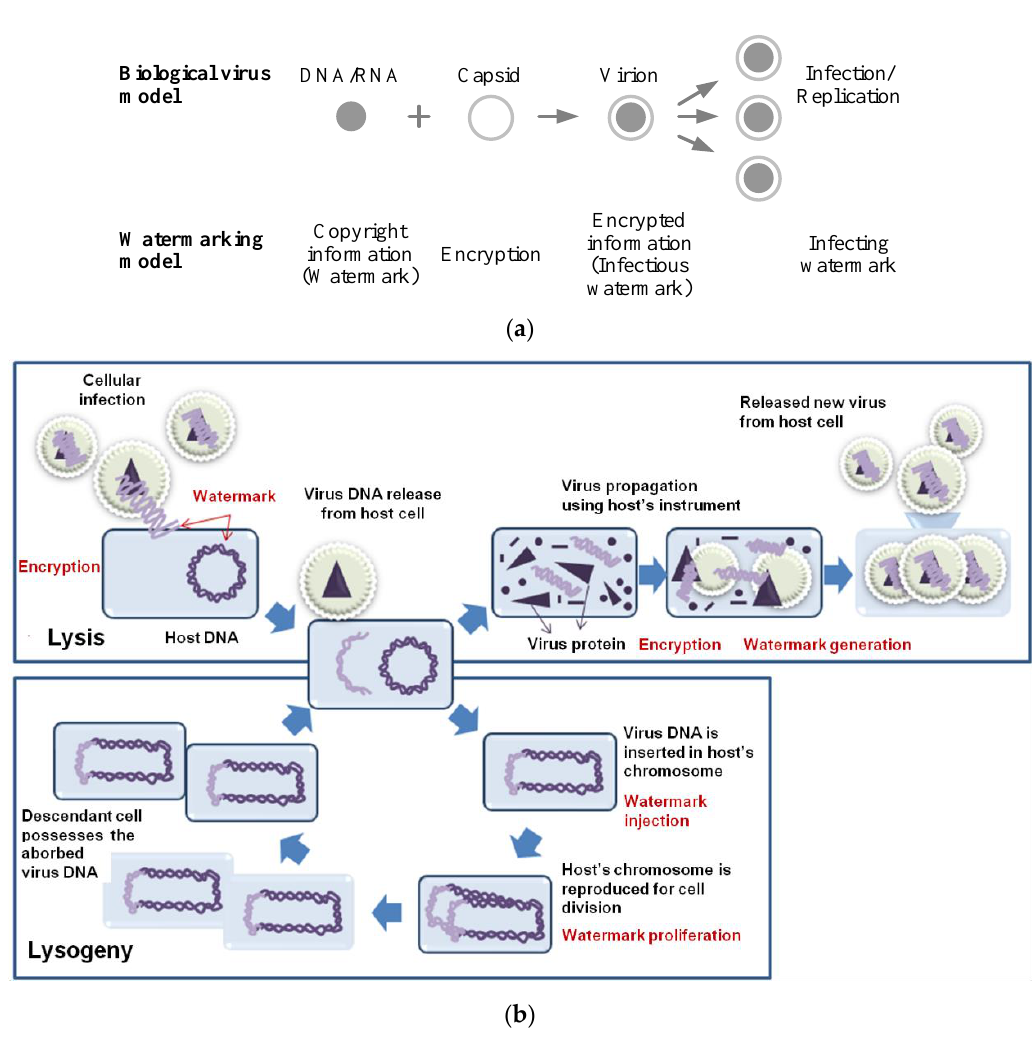
Figure 1. ( a ) Mapping of biological virus model to watermarking model and ( b ) virus infection process.